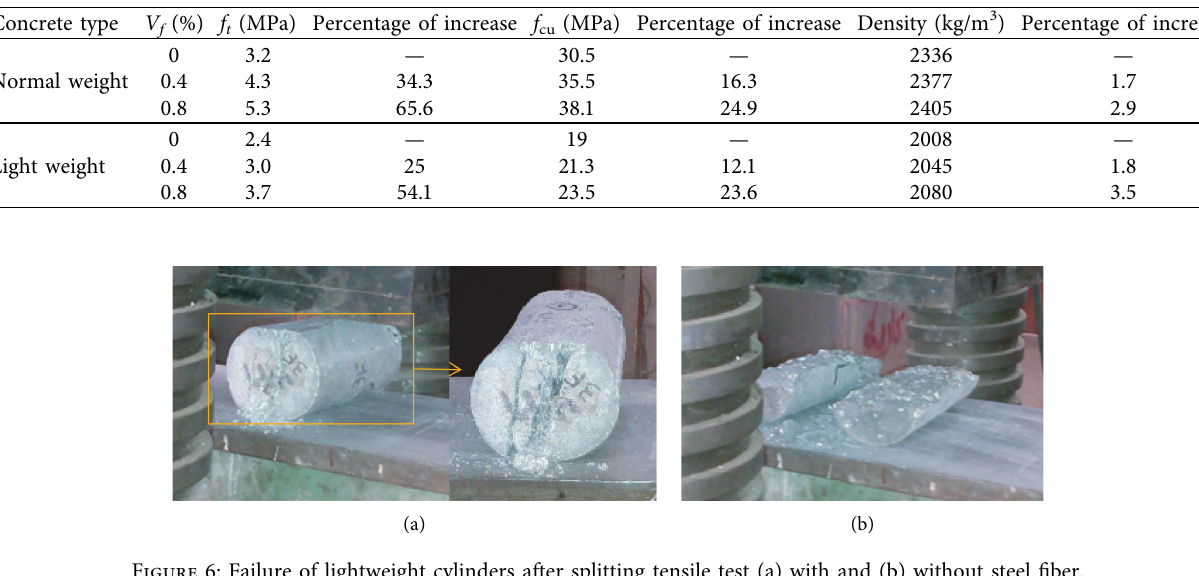
Table 8: Effect of steel fiber volume fraction ( V f ) on splitting tensile strength, compressive strength, and density of normal-weight and lightweight concretes.